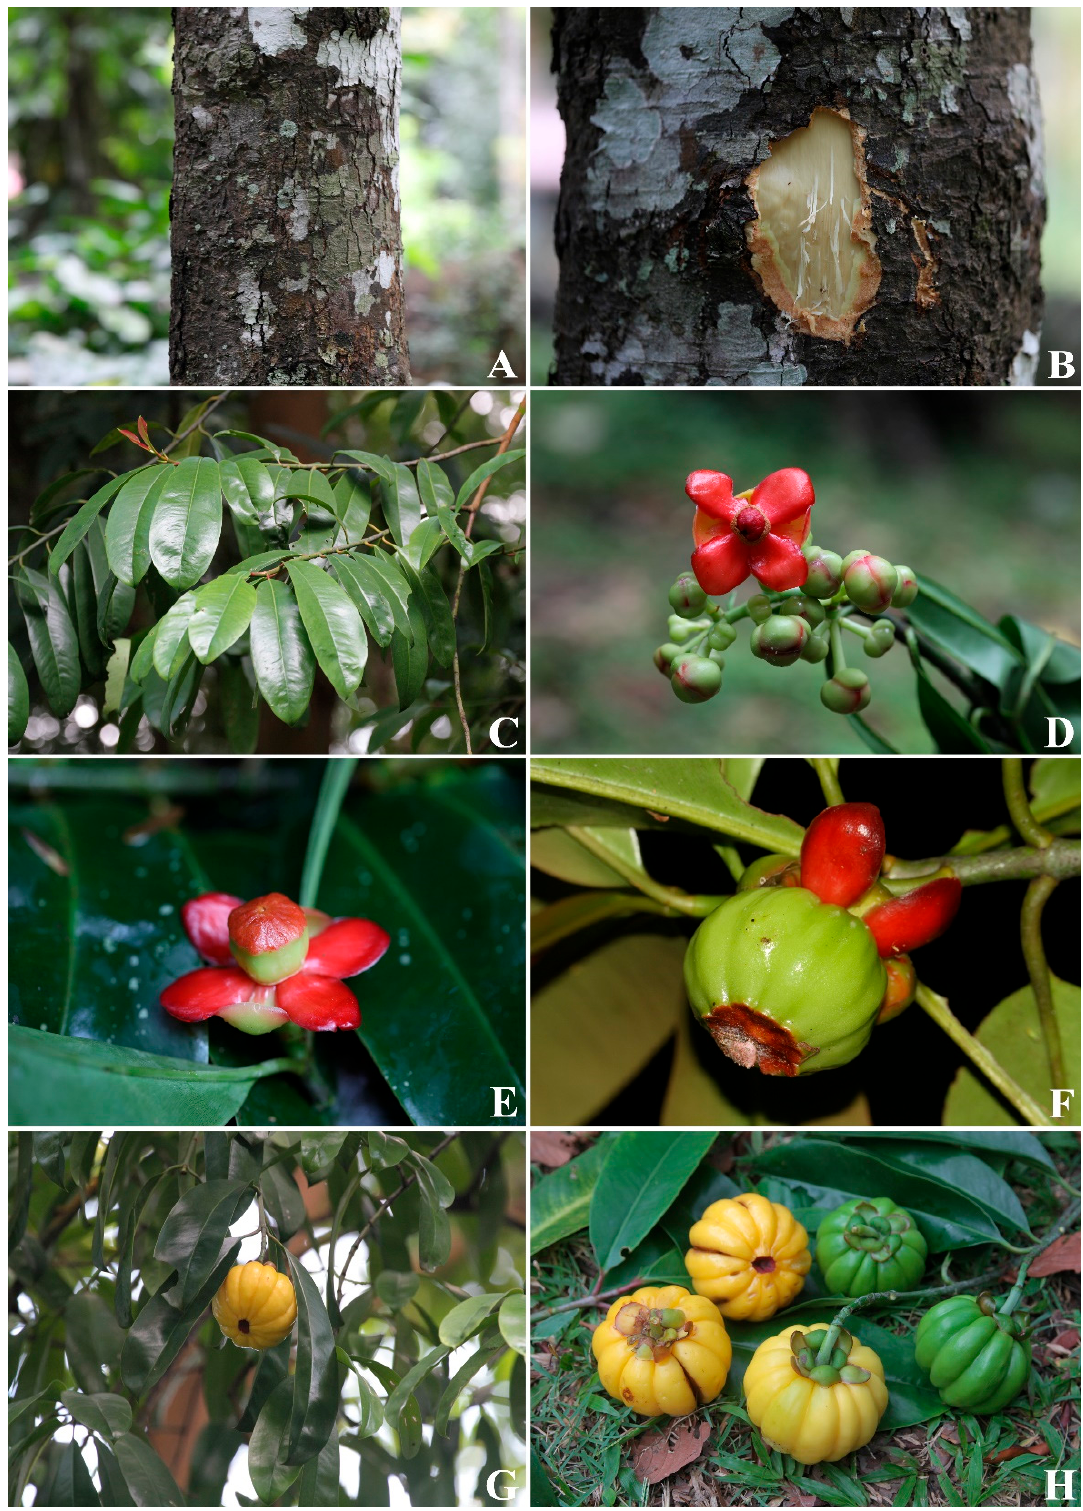
Figure 2. Garcinia atroviridis : ( A ) stem and outer bark; ( B ) outer bark and inner bark with colourless latex; ( C ) branches, young and mature leaves; ( D ) inflorescence with male flowers; ( E ) female flower; ( F ) young fruit; ( G ) fruiting branch; ( H ) mature and ripe fruits. Photos: Chatchai Ngernsaengsaruay.